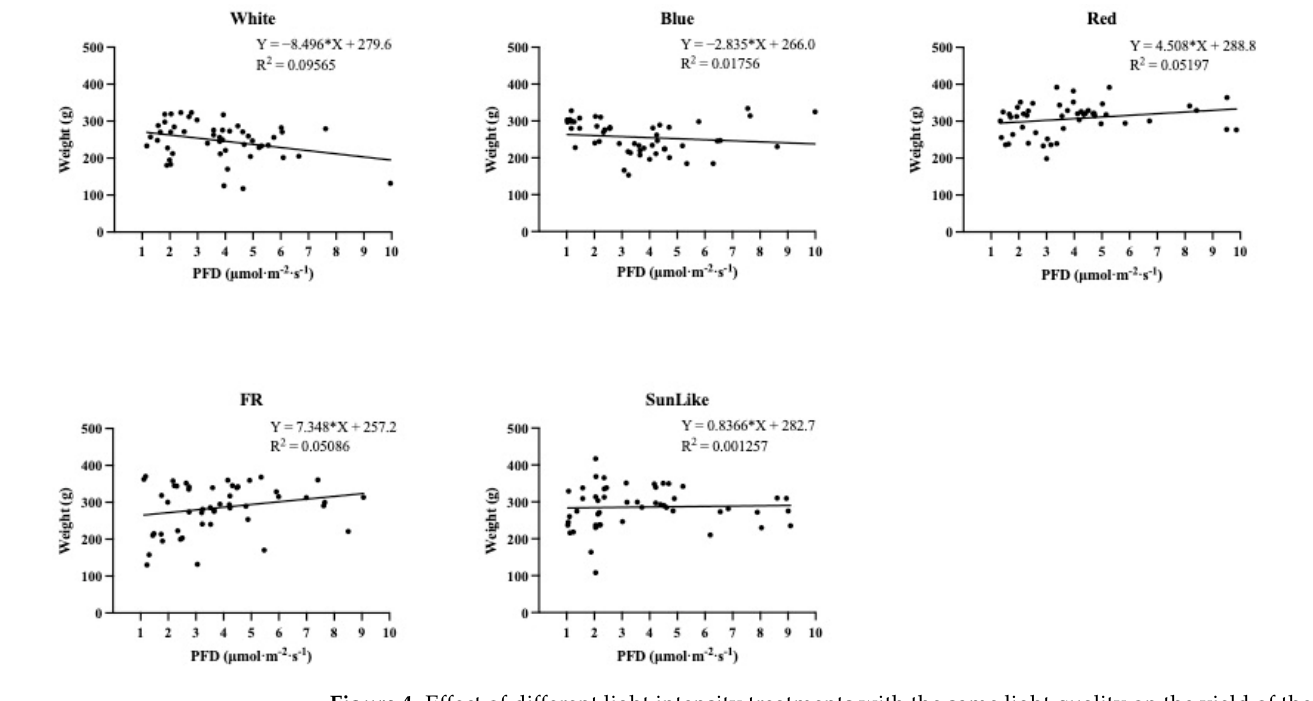
Figure 4. Effect of different light intensity treatments with the same light quality on the yield of the fruiting bodies of P. eryngii.